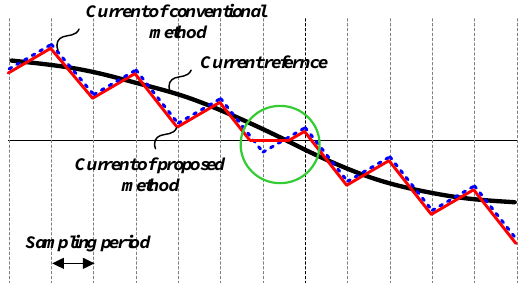
Figure 8. Occurrence of current discontinuity.